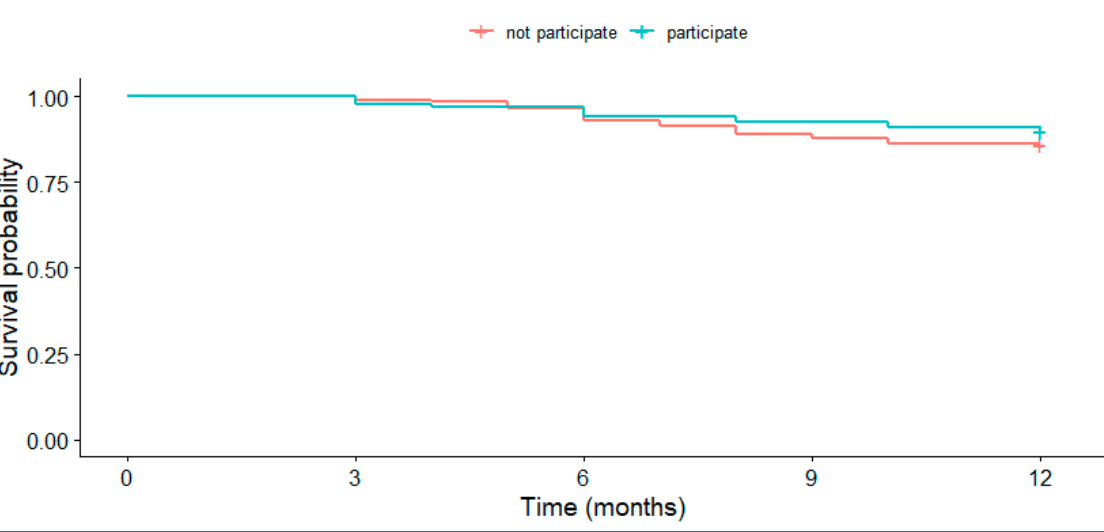
Figure 5. Extension of tax payment deadline program participation (P8).